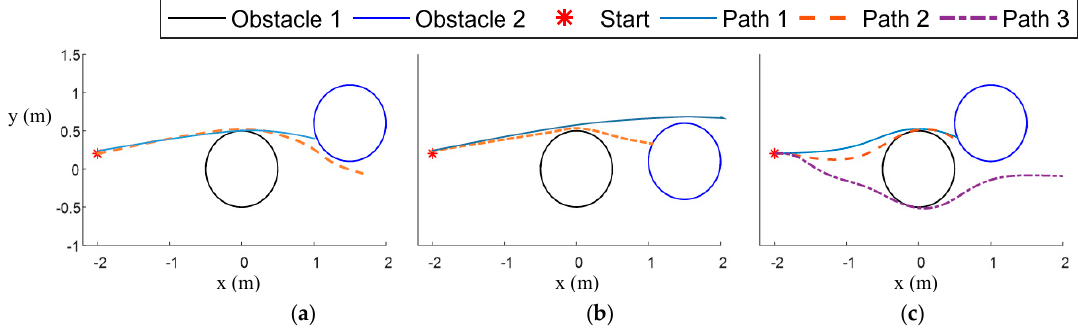
Figure 6. Sequential obstacle avoidance via sharp turn and low-curvature turn in the situation of different obstacle configurations ( a ) From the space between two obstacles; ( b ) From the same side of both obstacles; ( c ) From farther side .